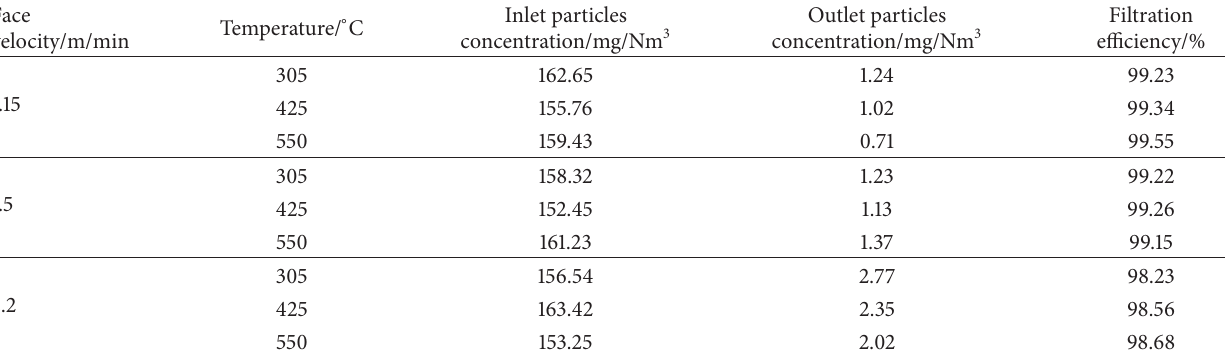
Table 3: Test results of particles concentration and filtration efficiency.